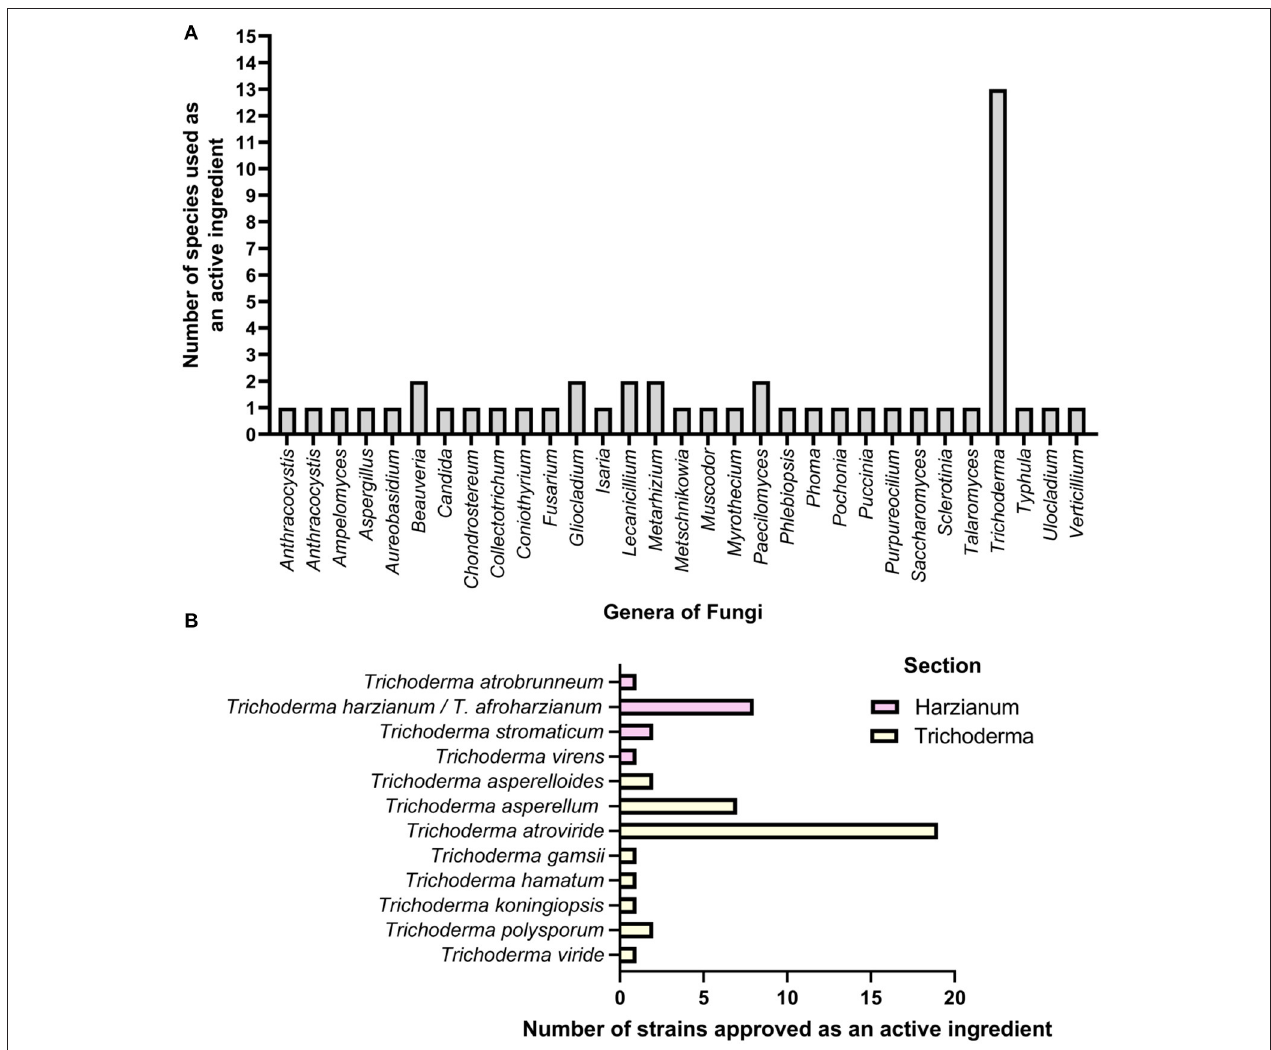
FIGURE 2 | The application of fungi as an active ingredient in commercially available products. (A) Fungal genera used as active ingredients in commercially available products. (B) The number of Trichoderma strains approved as active ingredients in 26 commercially available pesticides produced by five separate companies. T. harzianum and T. virens were co-active ingredients in four pesticides. T. asperellum and T. gamsii were co-active ingredients in five pesticides. A combination of multiple strains of T. atroviride were used in four